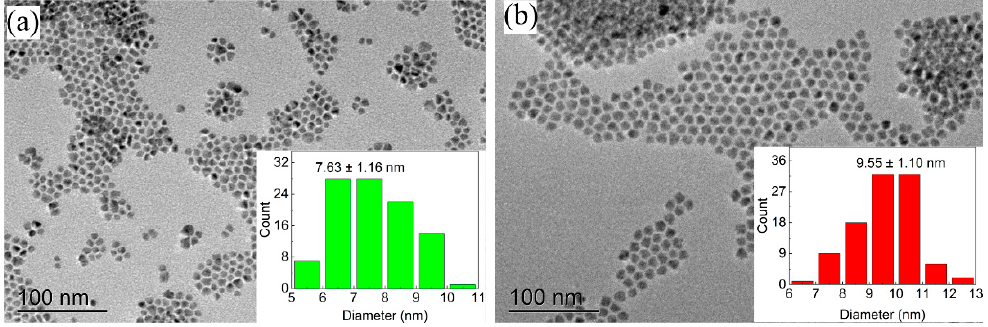
Figure 2. TEM graph of ( a ) GQDs and ( b ) RQDs; inset picture shows particle size distribution of QDs.